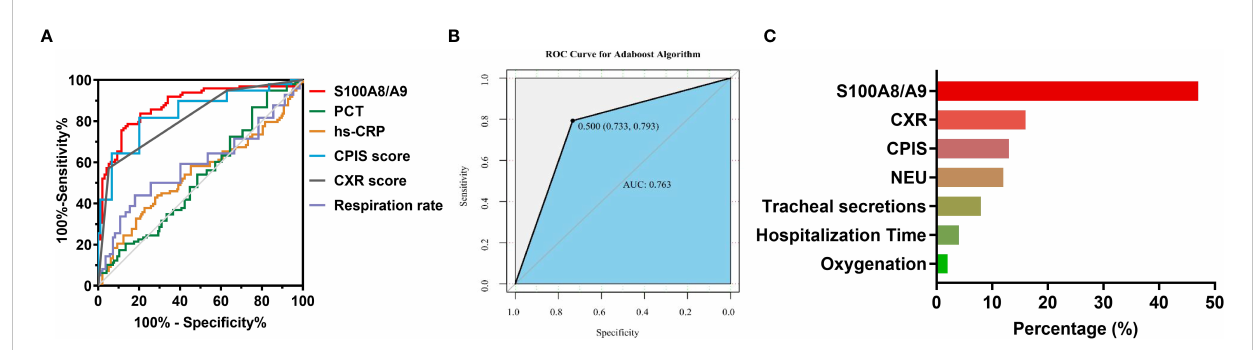
FIGURE 3 The diagnostic ef fi cacy of S100A8/A9 in the severity of children with CAP. (A) ROC curves for severity prediction by S100A8/A9, PCT, hs-CRP, CPIS scores, CXR scores and respiration rate. (B) ROC curves for boosting tree modeling after screening for indicators affecting the severity of CAP in